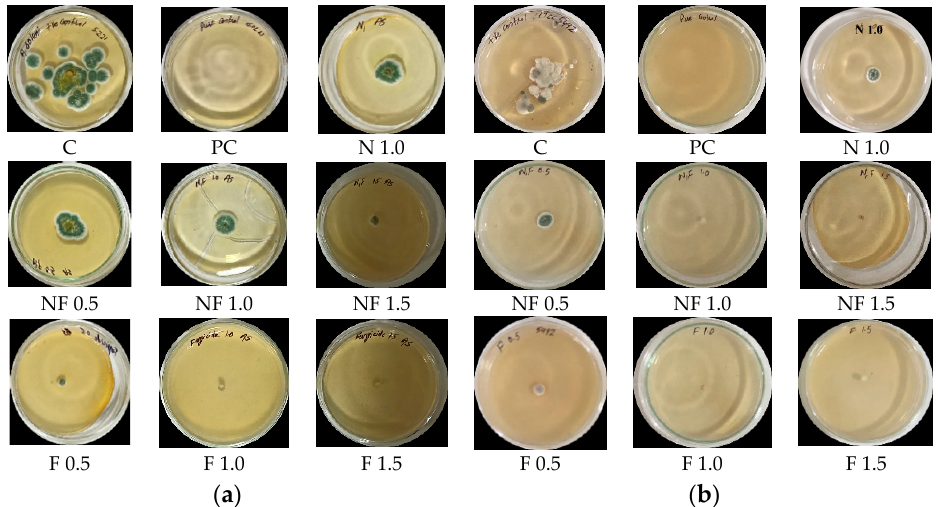
Figure 6. In vitro mycelium inhibition efficacy of CSGA NCs at three concentrations (0.5, 1.0, and 1.5 ppm) against potato pathogens: ( a ) A. solani ( b ) S. sclerotiorum ; where: C—control, PC—pure control (PDA alone), N 1.0-blank CSGA NCs at 1.0 ppm, NF—fungicide loaded CSGA NCs, F—commercial fungicide. Table 2. In vitro mycelium inhibition efficacy of CSGA nanocomposites.